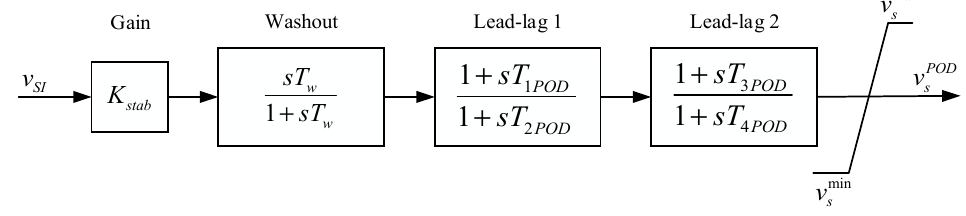
Figure 3. The structure of static var compensator power oscillation damper (SVC POD).